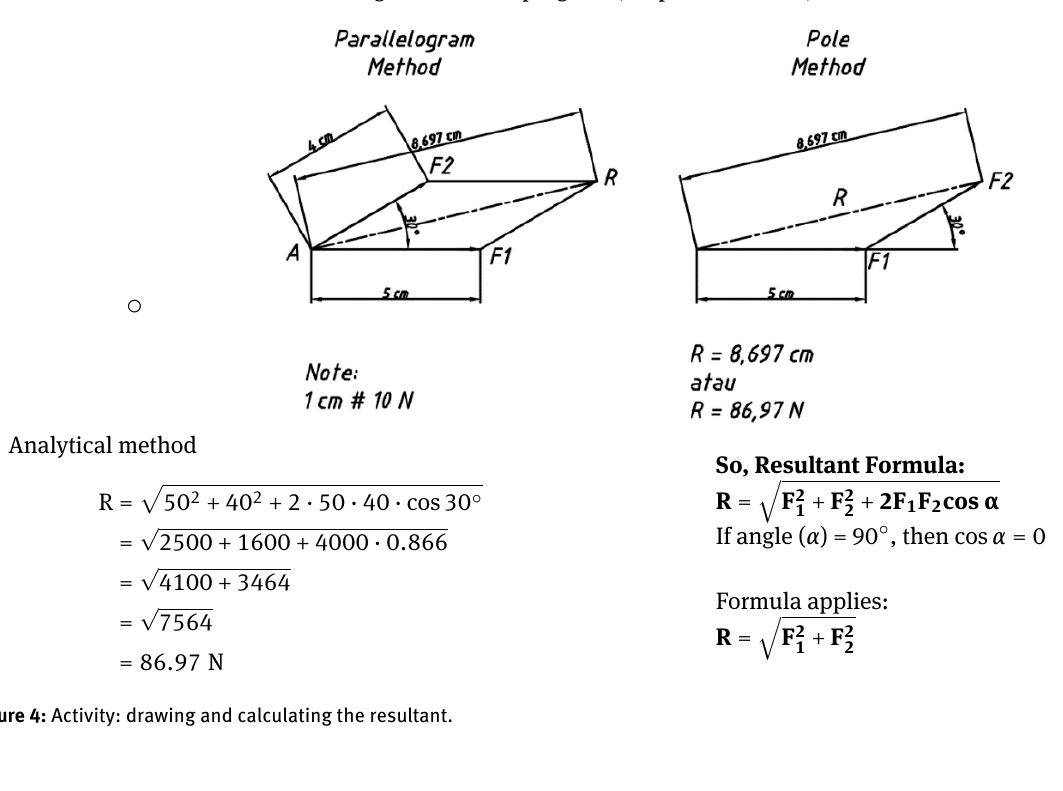
Purpose of Activity